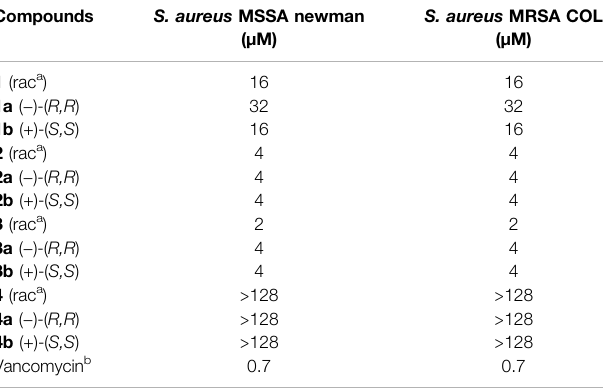
TABLE 1| MinimumInhibitoryConcentration(MIC) ofcompounds 1 to 4 against a methicillin susceptible (MSSA) and a methicillin resistant (MRSA) strain of Staphylococcus aureus